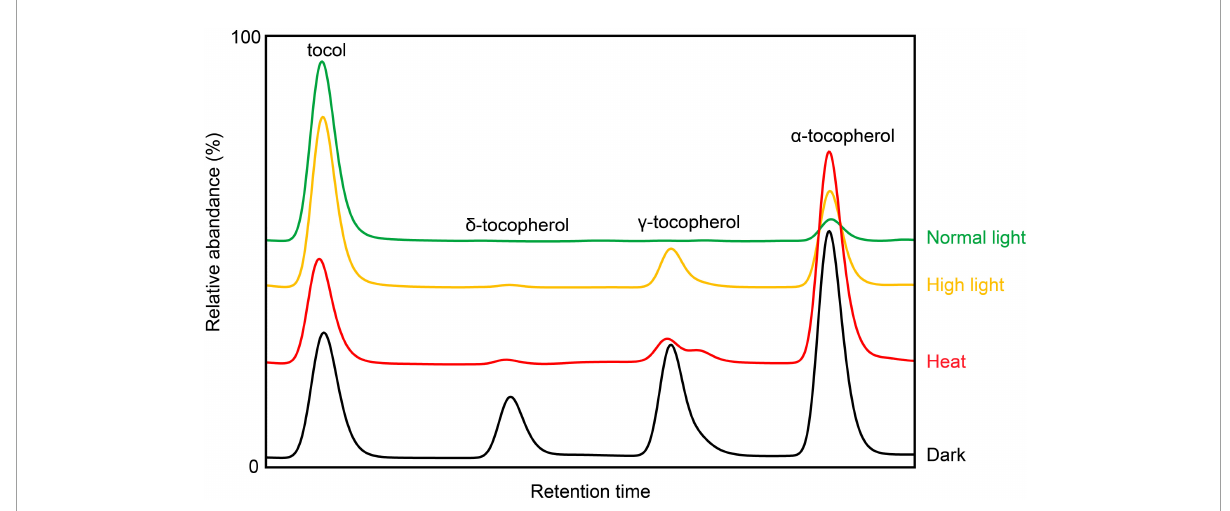
FIGURE2 Representative HPLC traces of Arabidopsis leaf tocopherols subjected to different growth conditions (high light, heat, and dark). Tocol is used as internal standard [based on Bao et al. (2020), with modification].